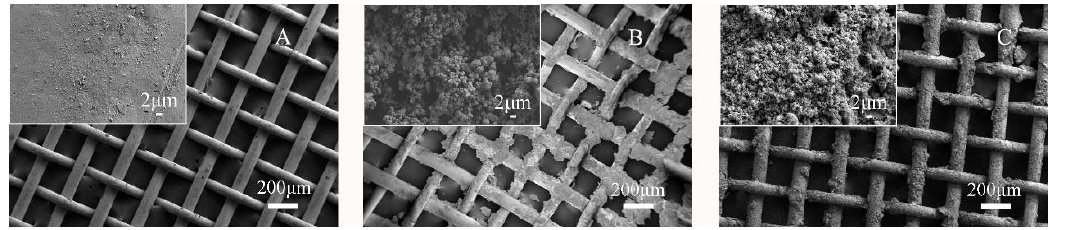
Figure 1. SEM characterization for the untreated ( A ), electrodeposited ( B ) and superhydrophobic brass mesh ( C ), respectively.